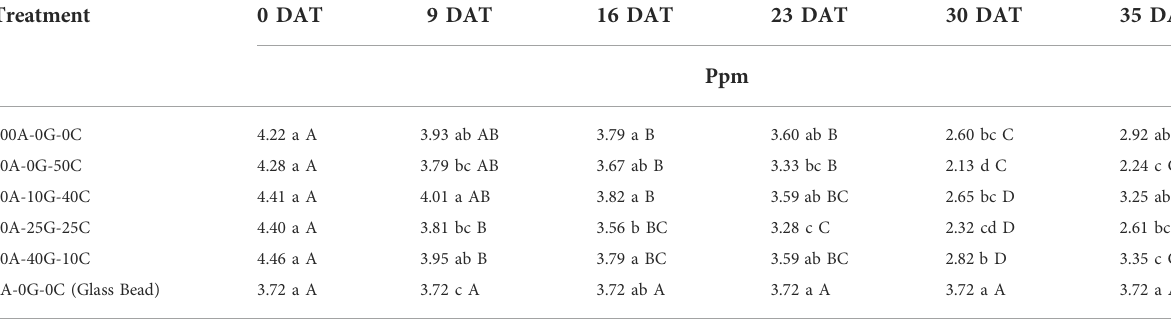
TABLE 5 Effect of treatment group on total phosphorus concentration at 0, 9, 16, 23, 30, and 35 days after treatment (DAT). Treatment